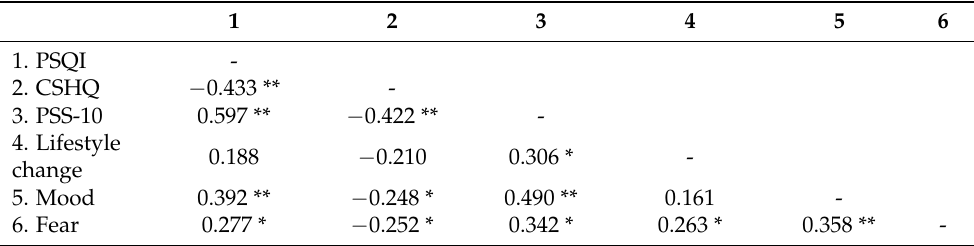
Table 5. Spearman’s correlation between sleep, behavioural and psychological variables during the lockdown in the total sample. * p ≤ 0.01; ** p ≤